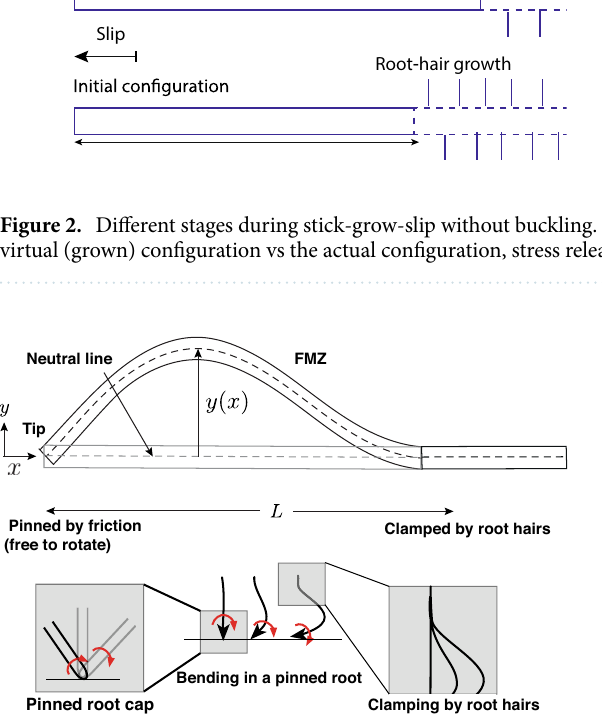
Figure 3. Geometry and boundary conditions: The freely moving zone is modeled as a thin elastic rod subject to a compressive force which arises from the combination of static friction at the tip and growth. On the right, the rod is clamped due to anchoring by root-hairs—it cannot change its position and its angle. On the left the rod is pinned—it can change direction but cannot move. For a large enough compressive force, the FMZ buckles, which allows for growth in the lateral direction, which is assumed to be on the surface of the agar, as is observed in the experiments. In the figure below, we show a possible mechanism for twisting of the